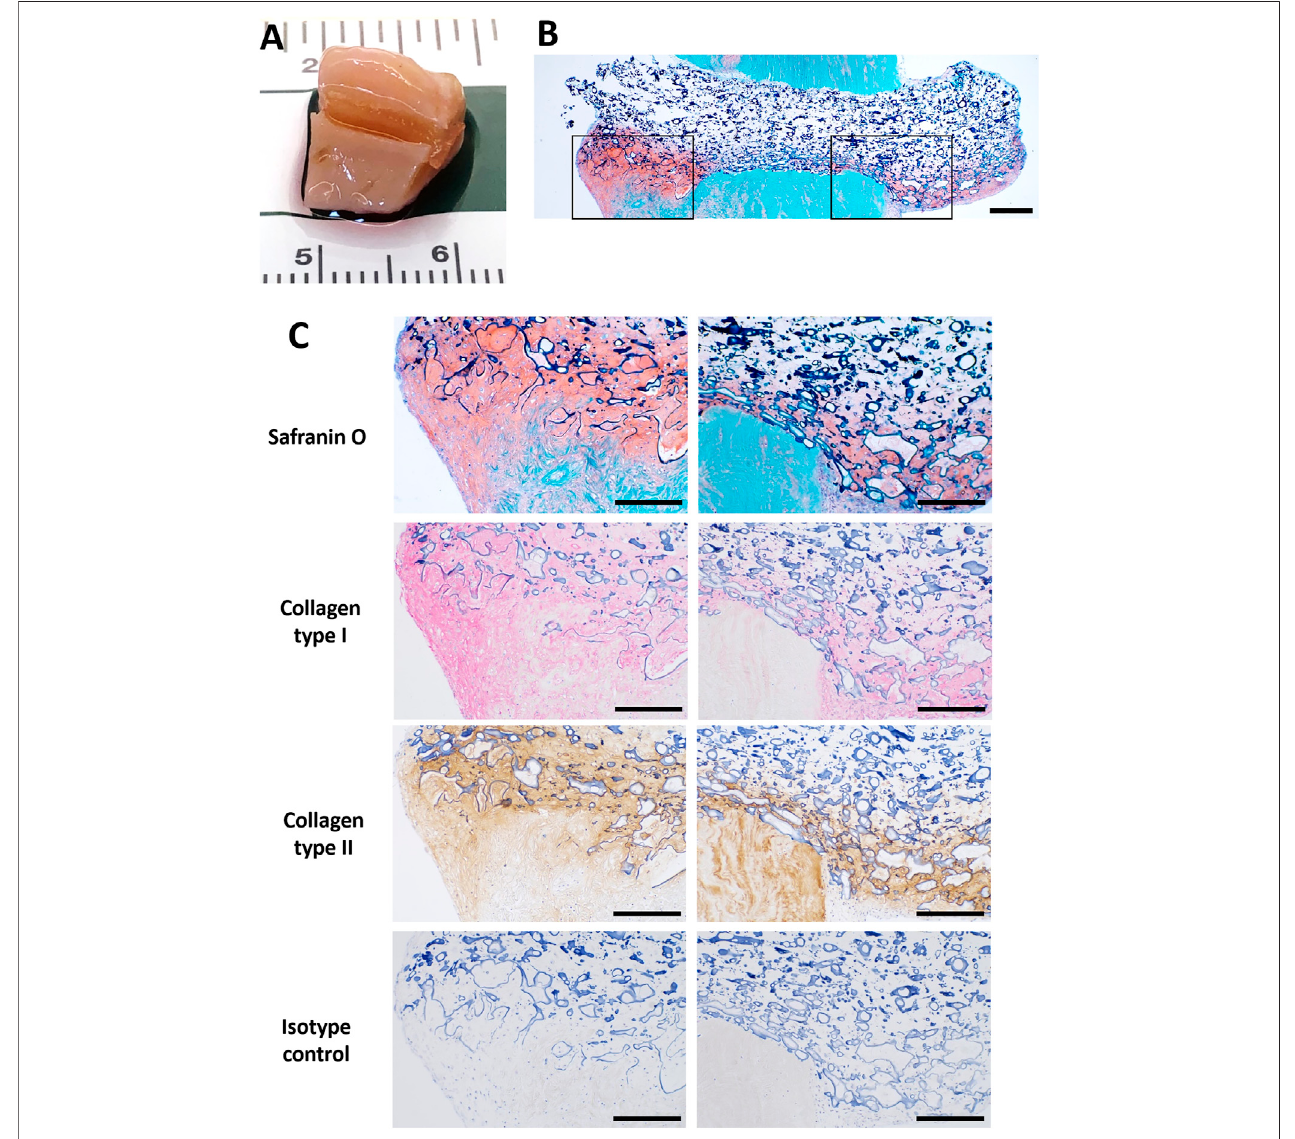
FIGURE6| PneumatospuncollagenscaffoldsseededwithhumanIPFPcellsandimplantedintohumanOAmeniscusexplant(72 year-oldfemale)andculturedfor 3 weeks. (A) Photograph of implanted scaffold. (B) Overview of section stained with Safranin O showing neotissue development in meniscus defect (bar = 500 μ m). (C) Histologic images ofsections stainedwithSafraninO and immunostained with collagen type I (APred), collagen type II (DAB brown), and isotype control regions ofinset regions outlined in (B) (bar = 300 μ m).